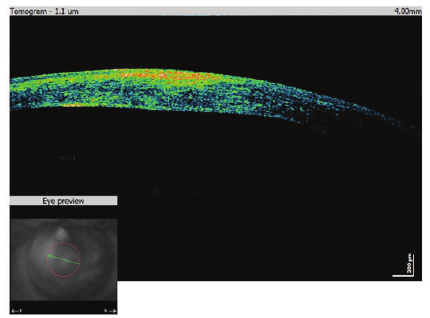
Figure 1: Slit lamp examination of the right eye.